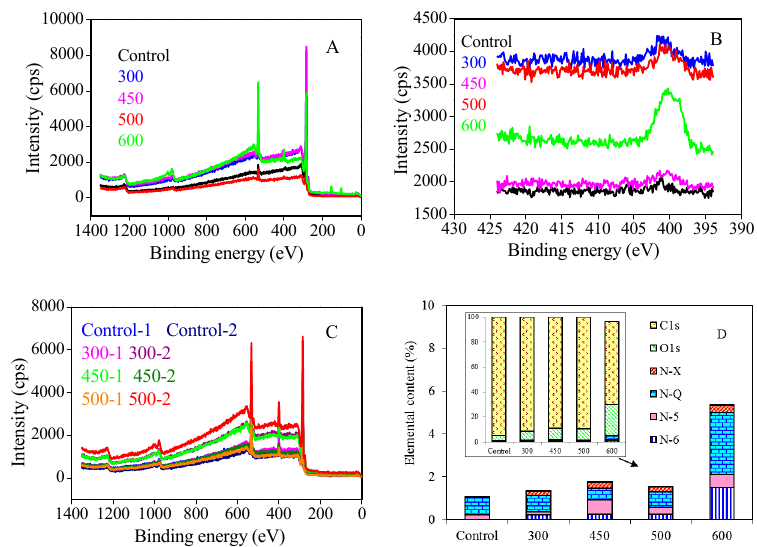
Figure 2. XPS analysis: ( A ) Wide spectrum of carbon fiber heated at different temperatures. ( B ) High-resolution N1s spectra of carbon fibers via different heat treatments. ( C ) Wide spectrum of used carbon fiber. ( D ) Peak separation results of high-resolution N1s spectra for carbon fiber heated at different temperatures.